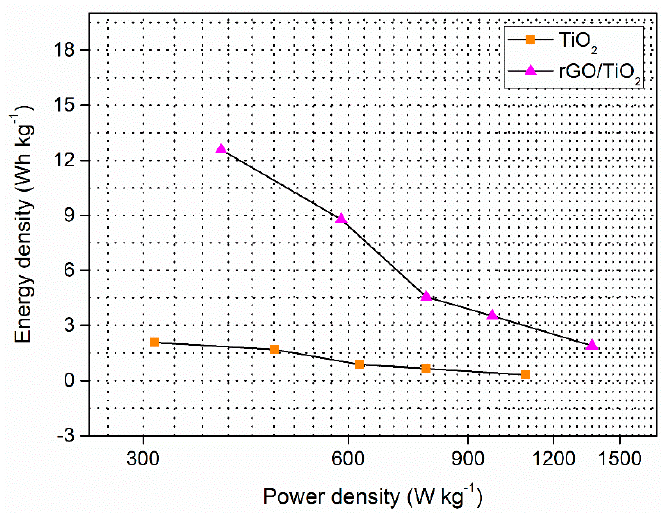
Figure 10. Ragone plot of the electrode.